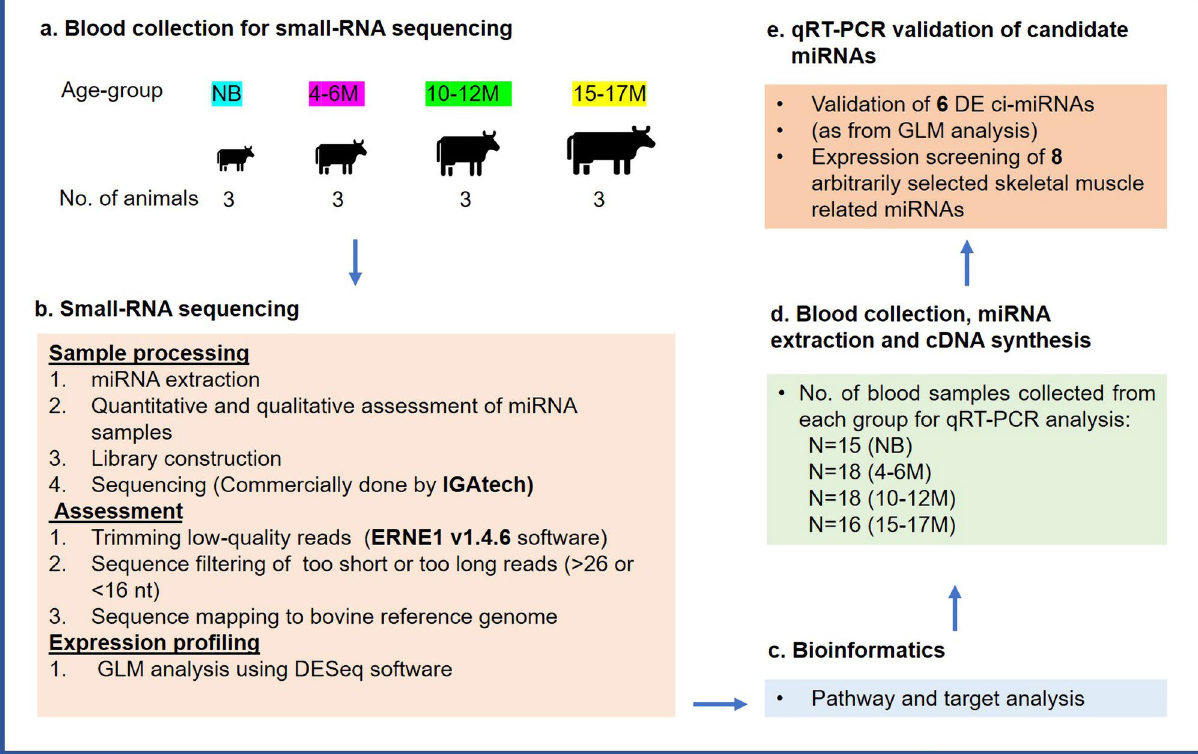
Figure 1. Schematic diagram of the study and workflow. ( a ) Target animal population divided into 4 groups (NB, 4–6M, 10–12M and 15–17M). Blood sampling was carried out from total 12 animals for Small RNA- Sequencing (3 per group). ( b ) For small RNA-Seq, sample processing (1 and 2) was performed whereas the sample processing (3 and 4), assessment (1, 2, 3) and expression profiling (1) were commercially performed by IGAtech, Italy. ( c ) Bioinformatic tools: TargetScan database was used to collect miRNA-mRNA target predictions to perform KEGG pathway analysis and specific target inspection. ( d ) Blood collection from total 67 animals, miRNAs extraction and cDNA synthesis. ( e ) qRT-PCR expression analysis of 14 selected